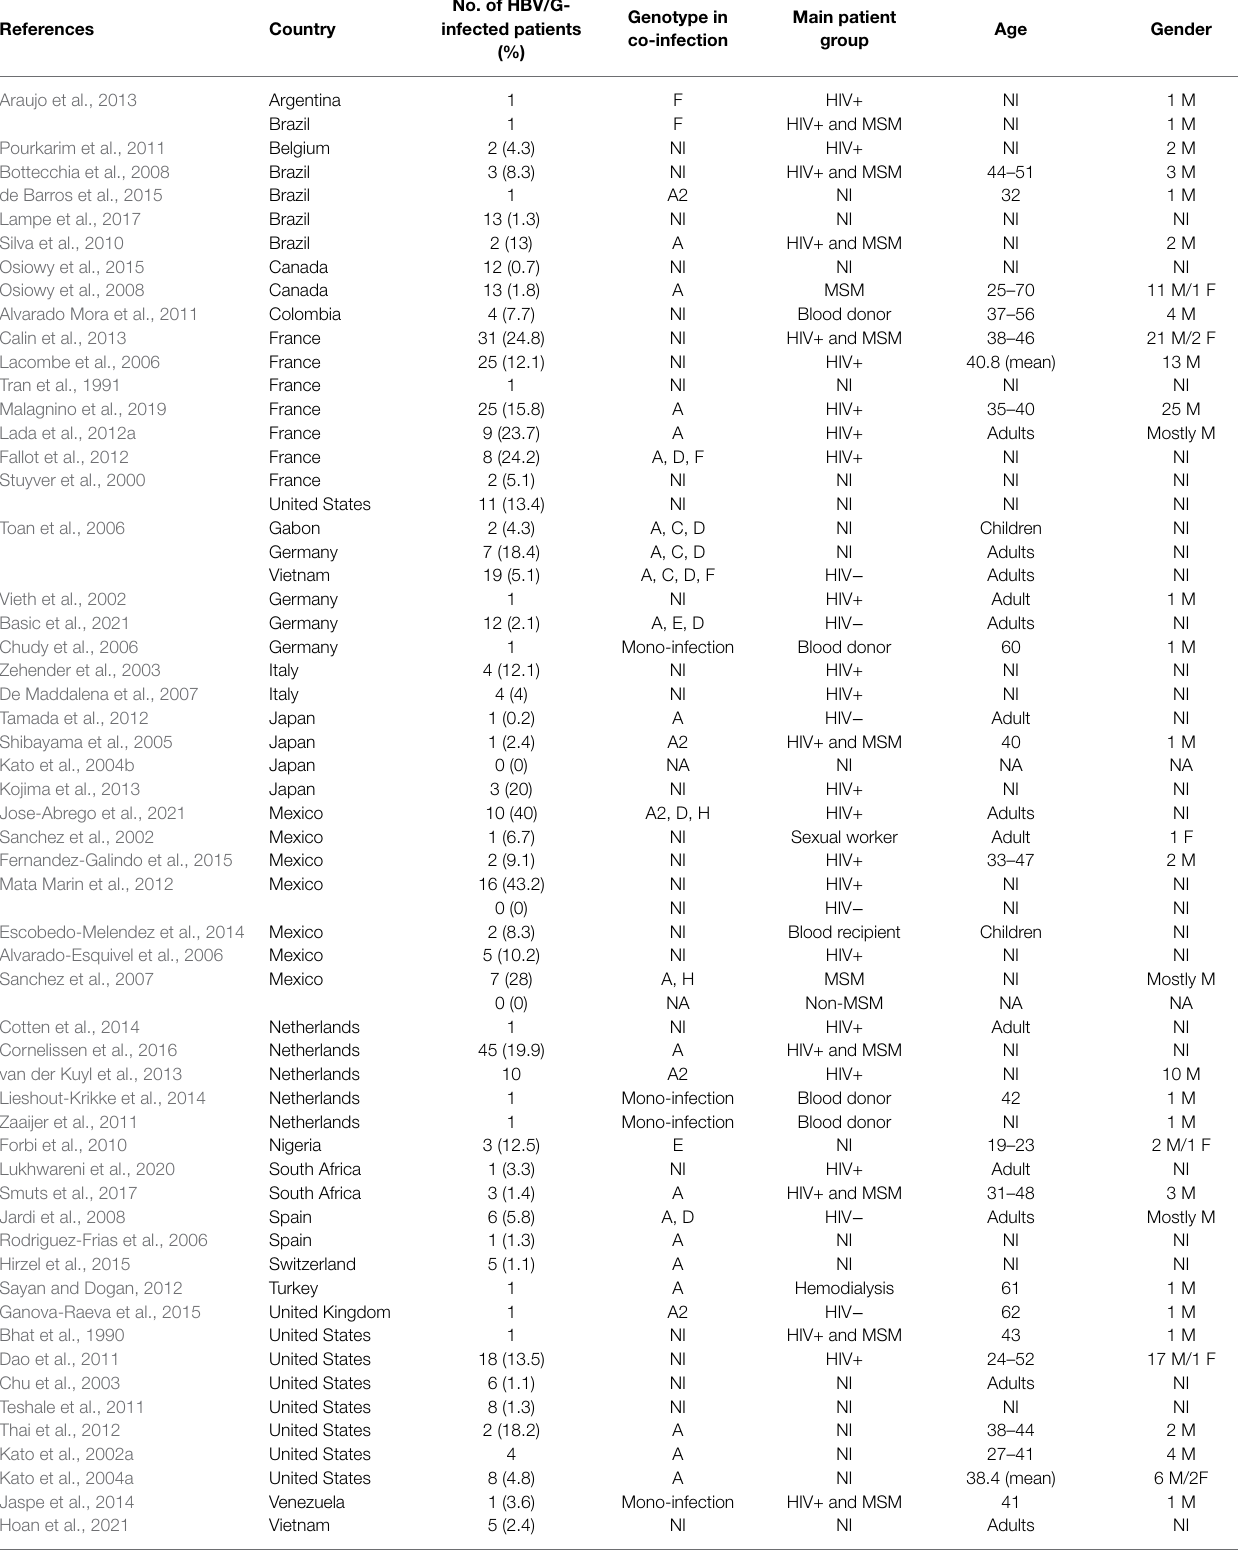
TABLE 1 | HBV/G-infected patient data from 55 literature